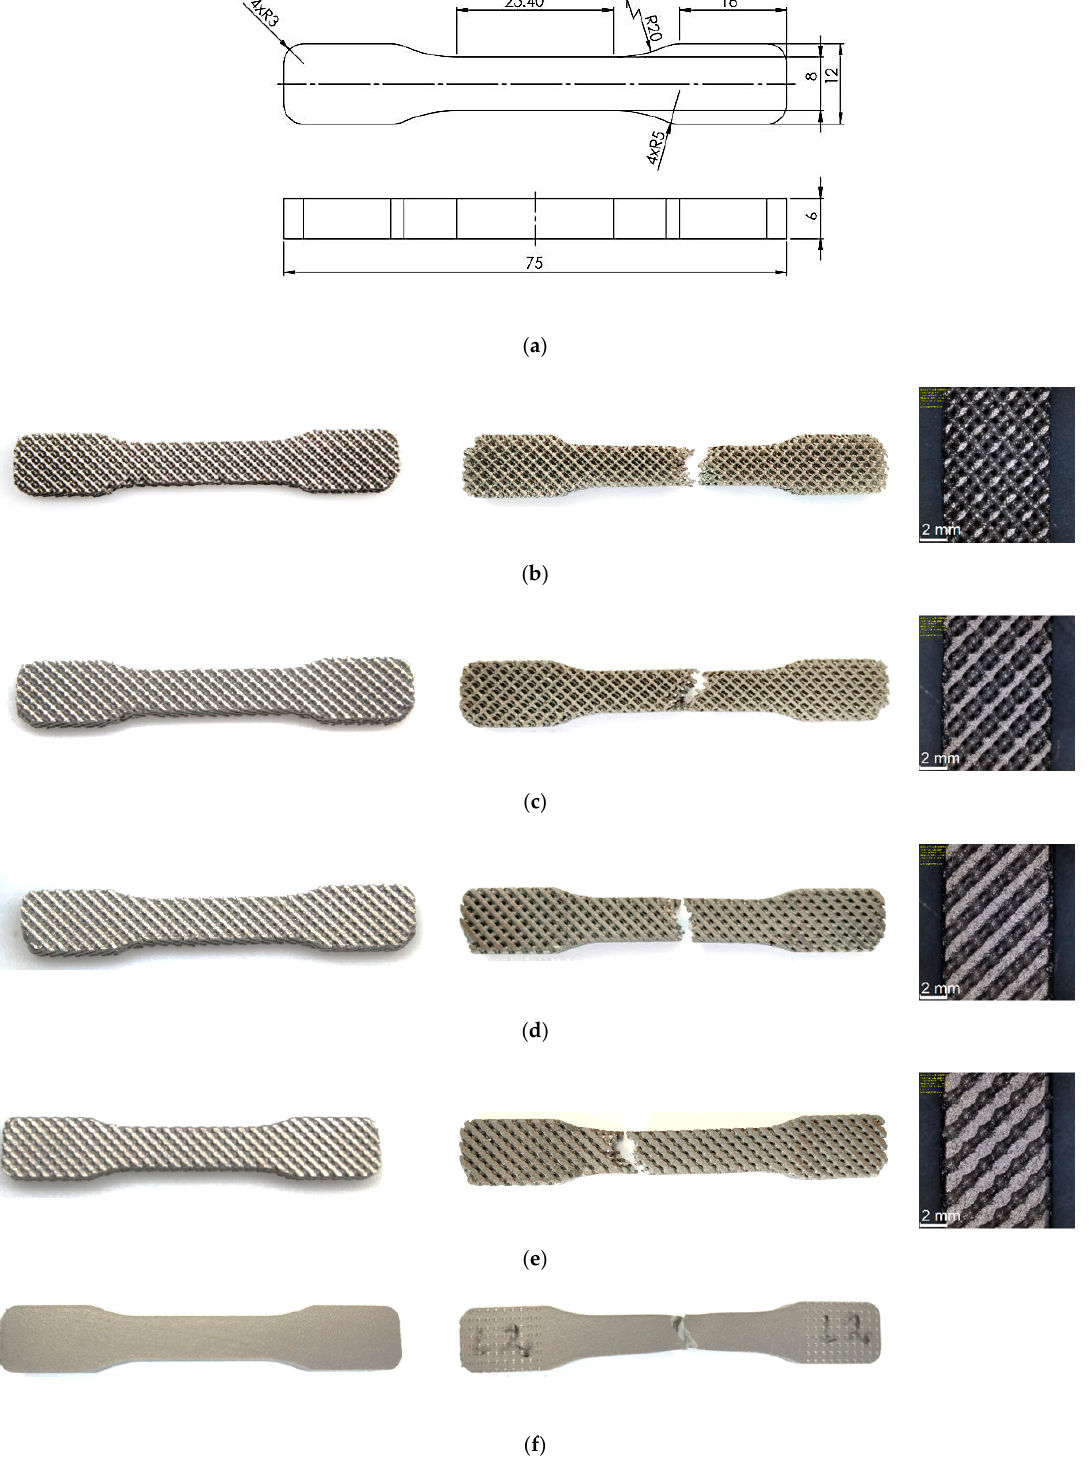
Figure 4. Dimensions of specimens for tensile testing ( a ) and specimens of Ti6Al4V titanium alloy printed by Laser Power Bed Fusion (LPBF) (before and after testing) with porosities: 81% ( b ); 73% ( c ); 50% ( d ); 34% ( e ) near 0 ( f